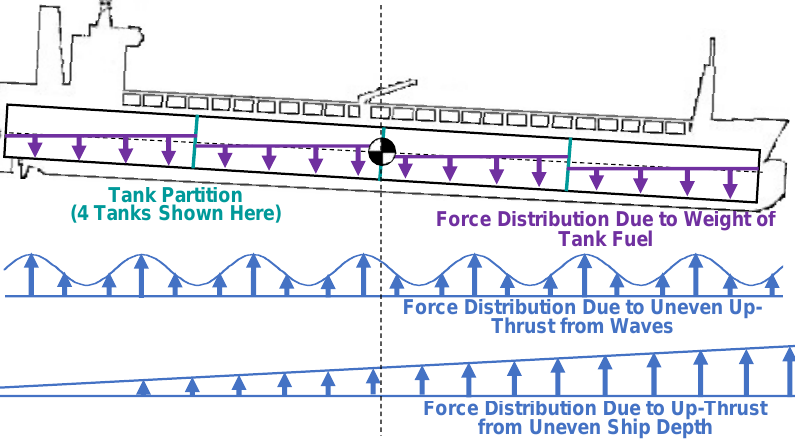
= 7 and BN = 9, and there is little variation in sea wave amplitude within this range [60]. The frequency of the fuel waves is assumed to be equal to the frequency of the sea waves, scaled by the ratio of the resultant velocity of the ship and the velocity of the sea. At a ship velocity of zero, the frequency of the fuel wave is thus equal to the frequency of the sea wave. Figure 3. Force distributions acting upon a tilting ship carrying liquid fuel. Figure 3. Force distributions acting upon a tilting ship carrying liquid fuel.